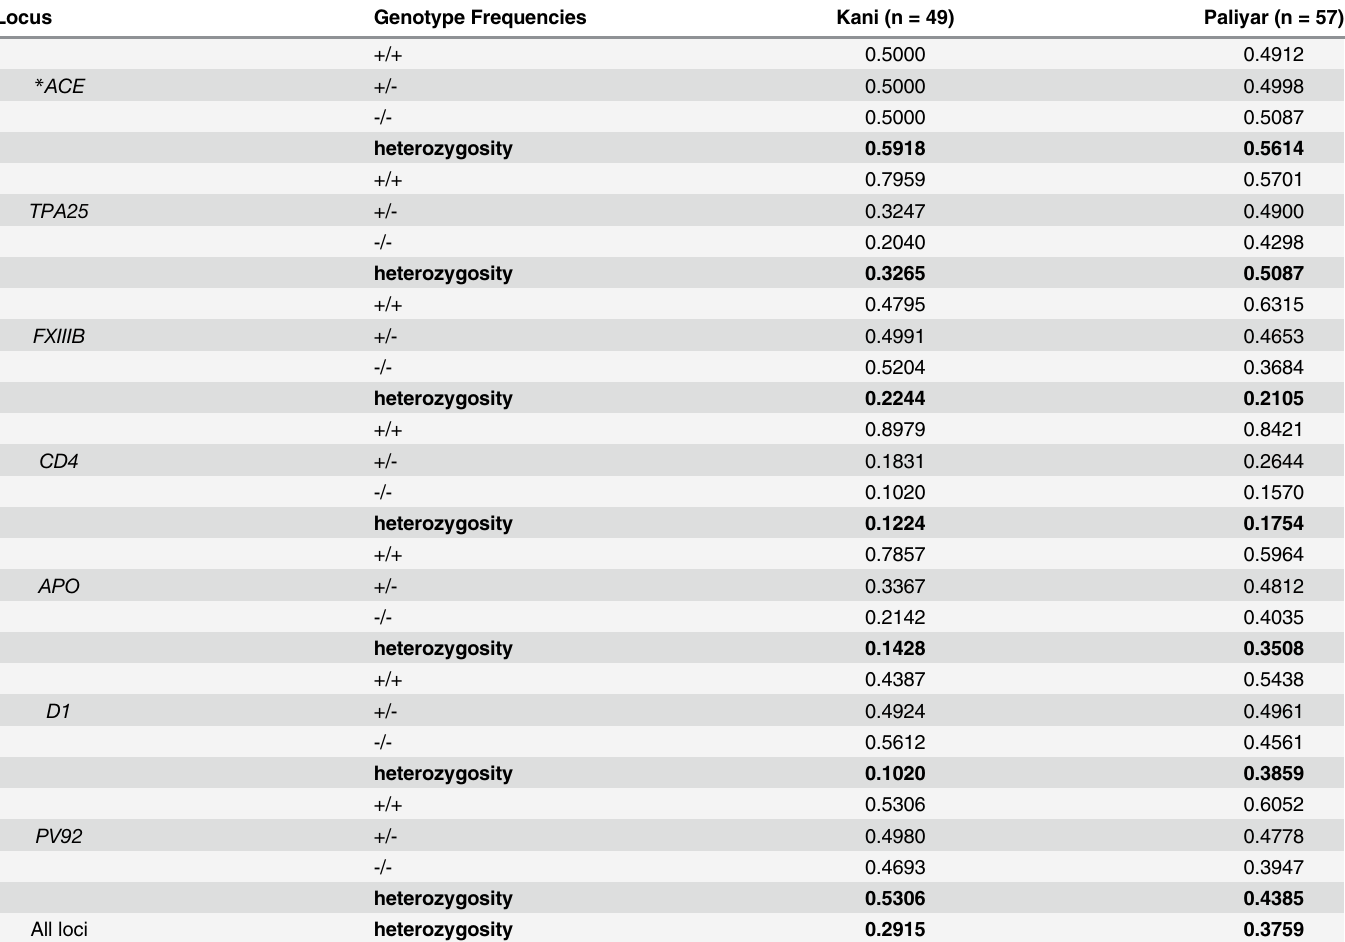
Table 1. Allele frequencies and hetrozygosities at 7 Alu loci in Kani and Paliyar tribes of Western Ghats of Tamil Nadu, South India.